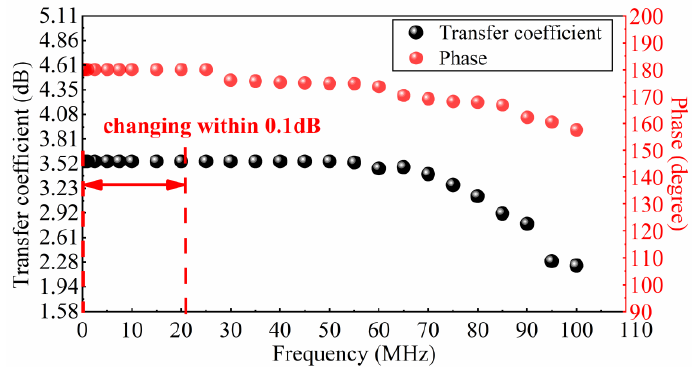
Figure 9. The sweep-frequency calibration result of the new signal conditioning sensor.